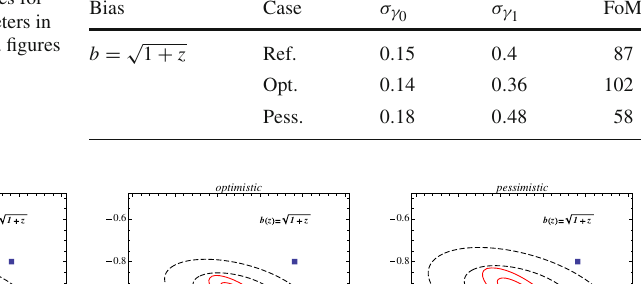
Table 9 Numerical values for 1 σ constraints on parameters in right panel of Fig. 20 and figures of merit